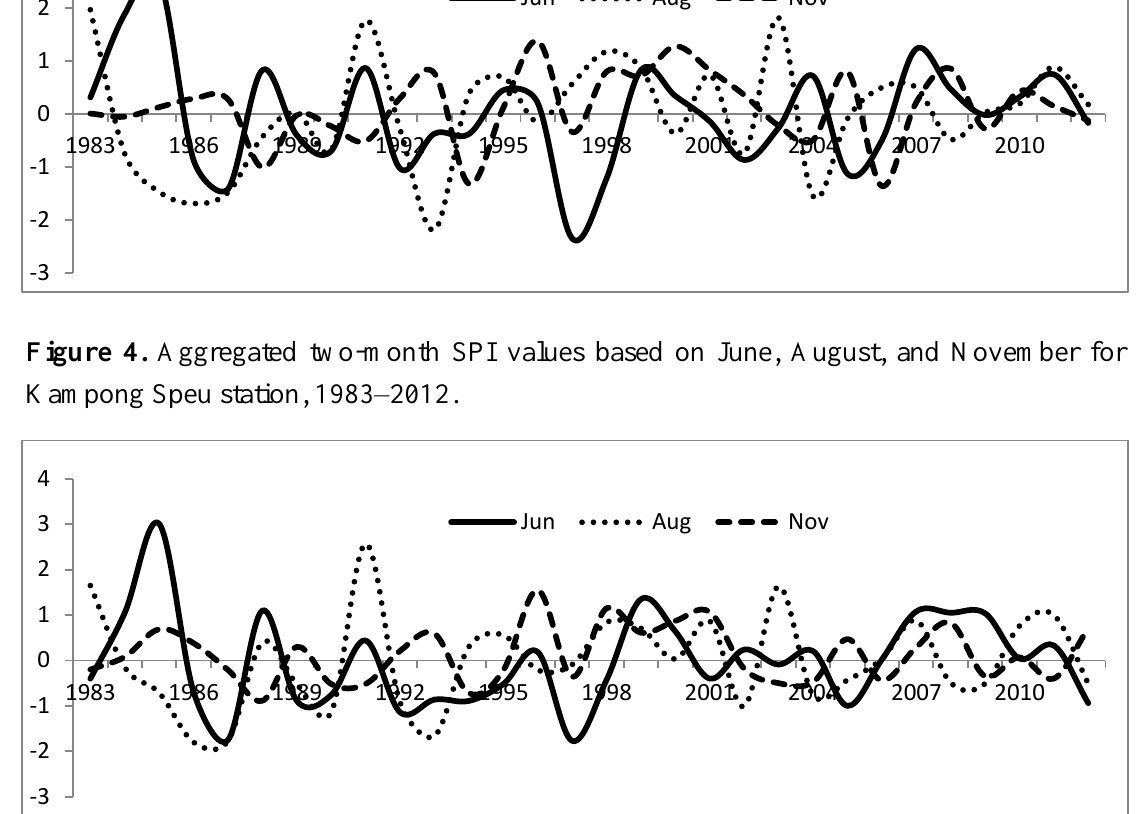
Figure 5. Aggregated three-month SPI values based on June, August, and November for Kampong Speu station,